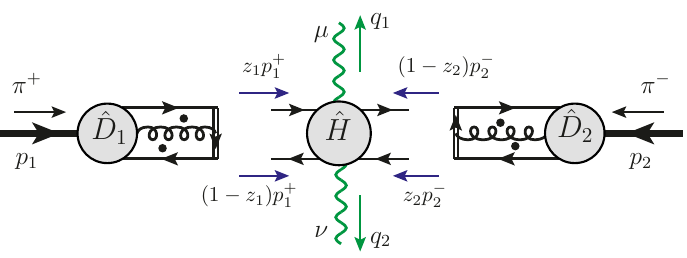
Figure 10. The factorized form for the exclusive ππ annihilation